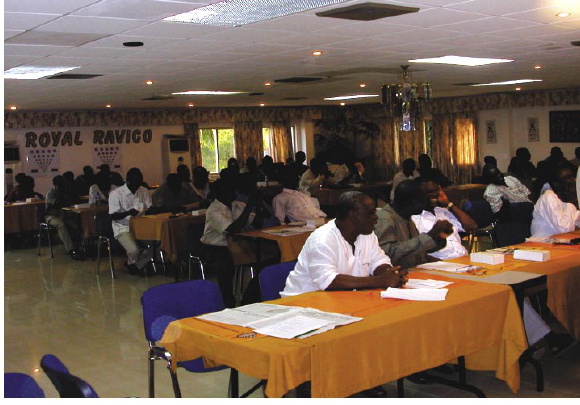
Figure 7. Coordinators attending the Train the Trainers course at The Royal Ravico Hotel in Accra.